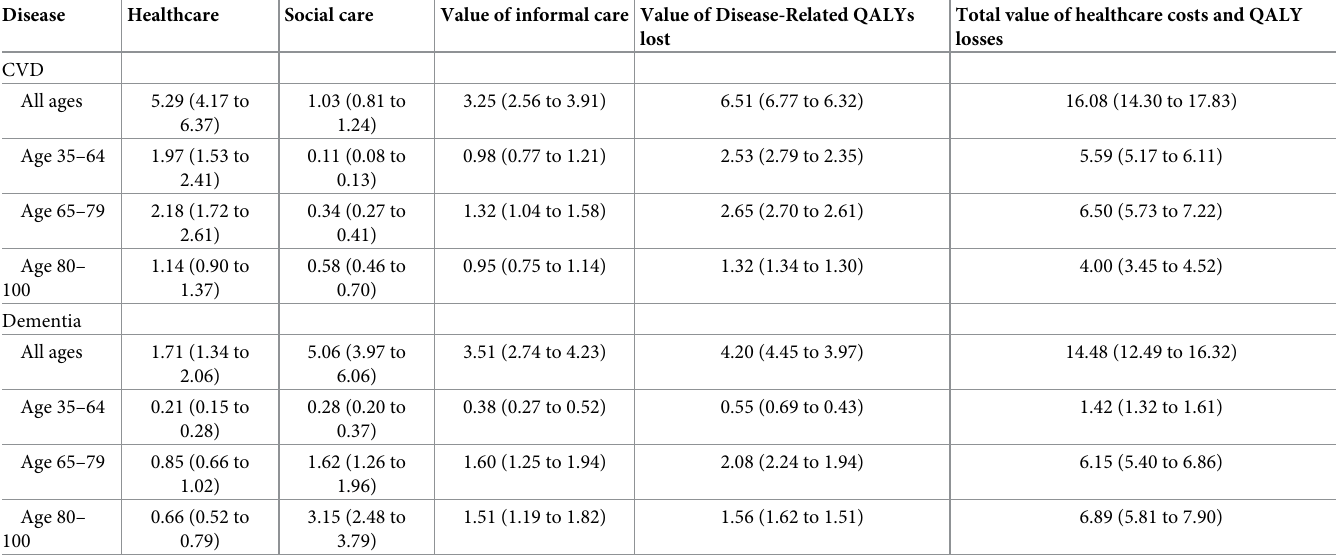
Table 2. Total cost of illness for CVD and dementia in 2020. £billions (2019 prices).